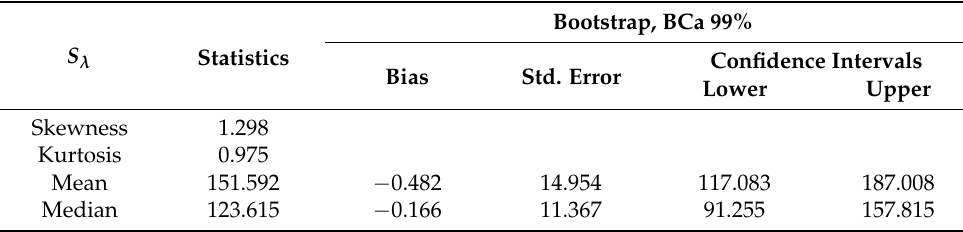
Table 4. Inferential statistics results of derived S λ for M70 decadal dataset at α = 0.01.